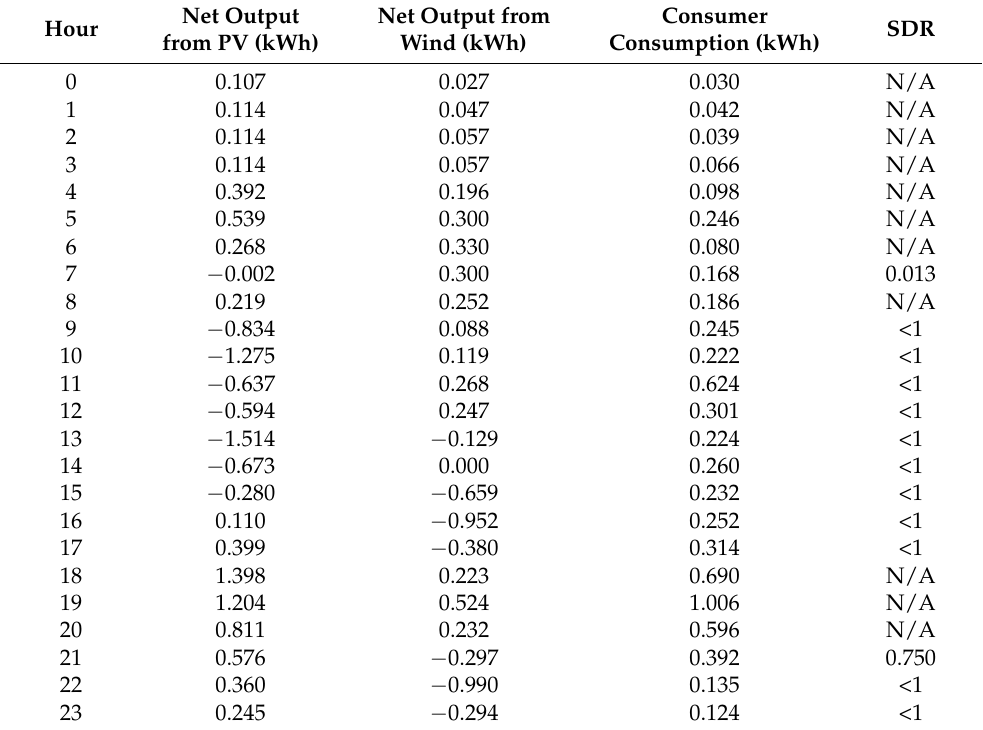
Table 2. Net generation of two prosumers, consumer consumption and